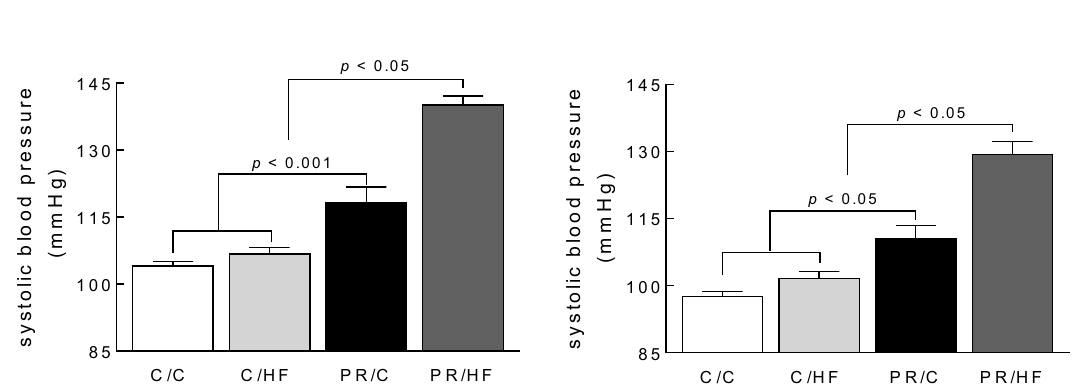
Figure 4. Systolic blood pressure in male and female offspring from dams on standard chow (C) or protein restricted (PR) diet during pregnancy. Weaned offspring were then fed either a high fat (HF) or C diet to adulthood, thus generating the dam/offspring dietary groups: C/C, C/HF, PR/C and PR/HF. All values are reported as means ± SEM. (n = 7–11 per group) and analysed using a one-way ANOVA with Tukey–Kramer post hoc test.